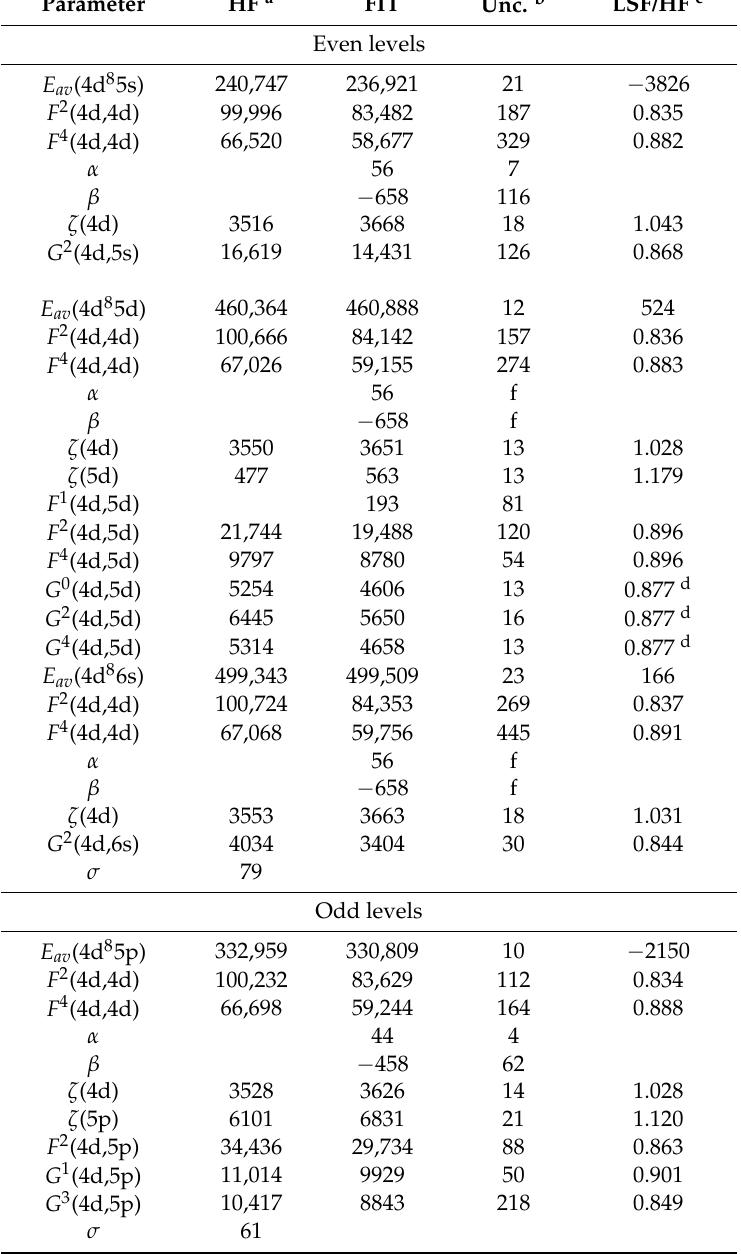
Table A4. Fitted (FIT) with their uncertainties (Unc.) and Hartree–Fock (HF) energy parameters in cm − 1 of the 4d 8 5s, 4d 8 6s, 4d 8 5p and 4d 8 5d configurations in Sn VI calculated with the Cowan